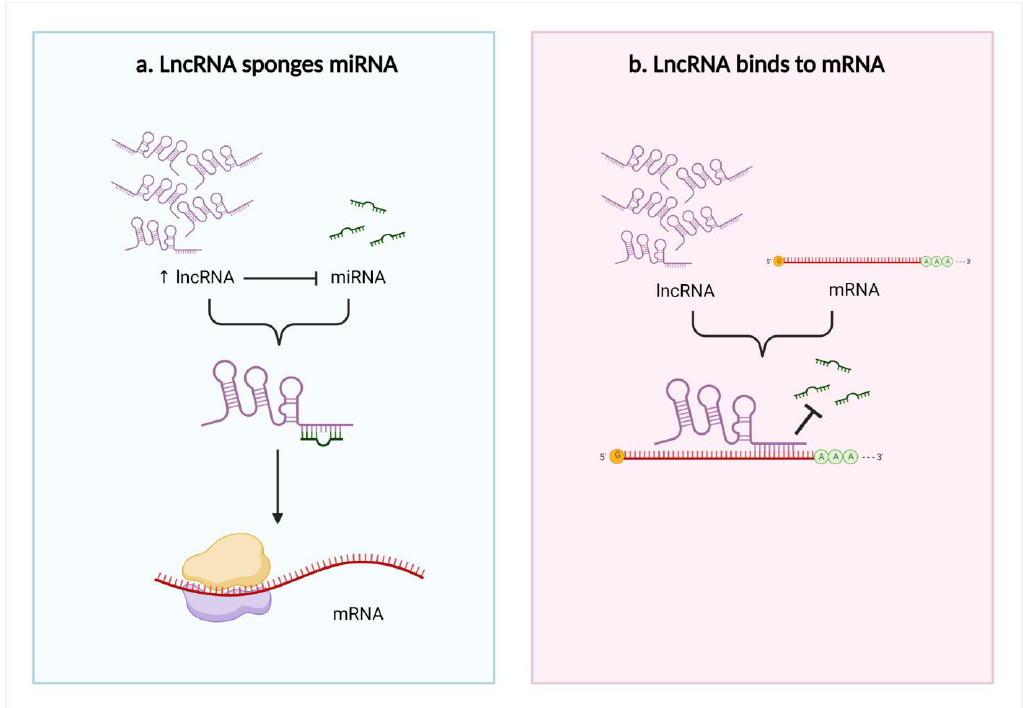
Figure 1. LncRNAs act as ceRNAs: ( a ) A lncRNA sponges miRNA to prevent them from inhibiting their target mRNA. ( b ) A lncRNA forms double-stranded RNA complexes with an mRNA to pre- vent miRNAs from binding . Blunt arrows ( ┴ ) indicate inhibition while sharp arrows ( → ) indicate stimulation.